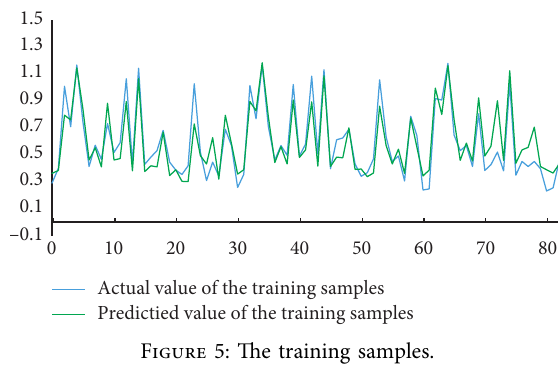
Figure 5: The training samples.